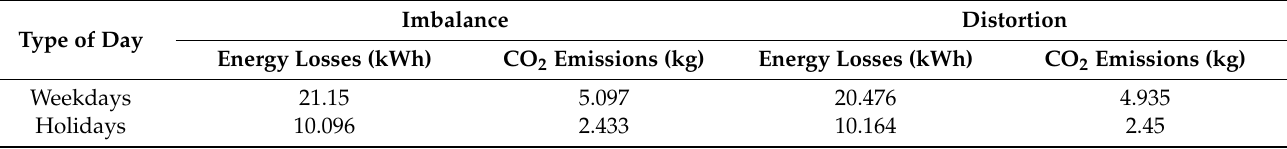
Table 7. Annual energy losses and CO 2 emissions caused by imbalances and distortions in the transformer operation. Type of